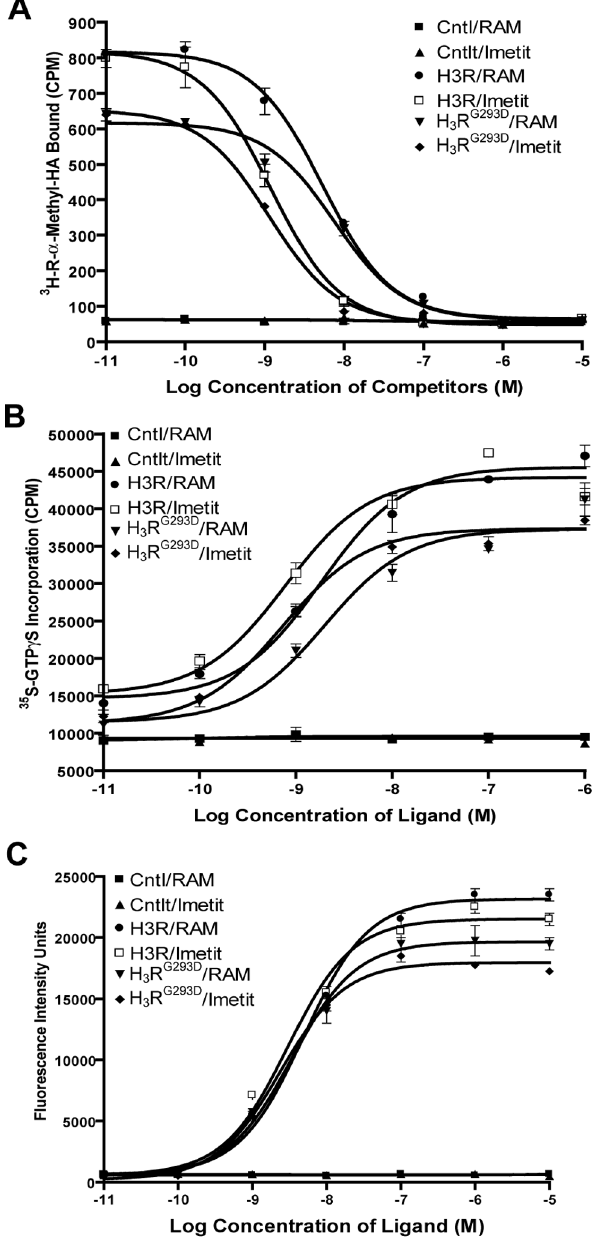
Figure 2. Pharmacological comparison of Hrh3 allele function- ality. ( A ) Characterization of H 3 R and H 3 R G293D using radioligand binding assays. Plasmids carrying Hrh3 cDNA for the indicated alleles were transiently transfected into COS-7 cells. Cell membranes from transfected cells were used in radioligand binding assays with 3H-RAM- HA as the tracer in the presence of various concentrations of unlabeled RAM-HA and Imetit as the competitors (see Materials and Methods). Membranes from mock transfected COS-7 cells were used as the negative controls (Cntl). ( B ) Functional comparison of H 3 R and H 3 R G293D in GTP c S binding assays. Membranes from CHO cells transiently expressing H 3 R cDNA for the indicated alleles were stimulated with various concentrations of RAM-HA and Imetit in the presence of 35S- GTP c S as the tracer (see Materials and Methods). Membranes from mock transfected CHO cells were used as the negative control (Cntl). ( C ) Functional comparison of H 3 R and H 3 R G293D Ca2 + mobilization assays. 293T cells co-expressing Gqi5 and H 3 R or H 3 R 293D were stimulated with different concentrations of RAM-HA and Imetit. The ligand-stimulated Ca 2 + mobilization was monitored using a FLIPR instrument